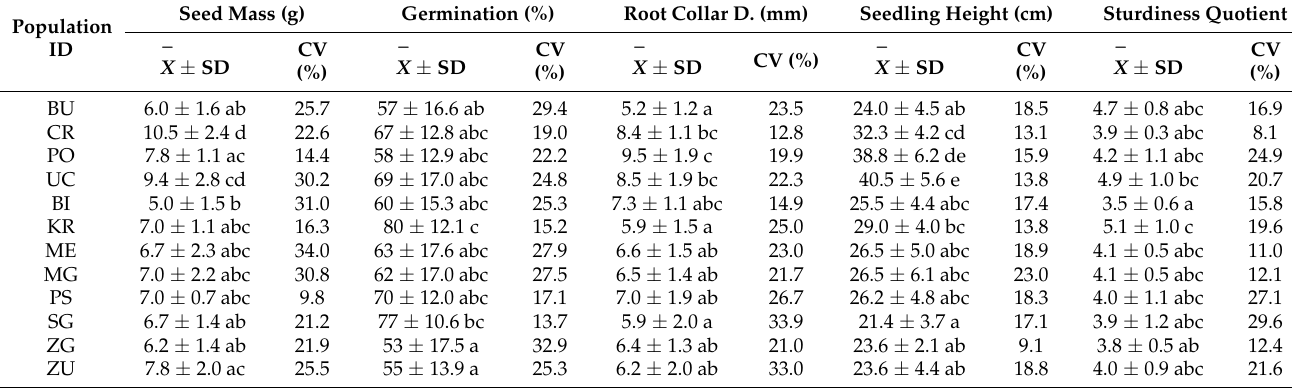
Table 1. Arithmetic means (X ), standard deviations (SD) and coefficients of variation (CV) for seed mass (SM), germination rates, seedling height (SH), root collar diameter (RCD) and sturdiness quotient (SQ) in 12 sweet chestnut populations. Popu- lation ID: BU—Buje; CR—Cres; PO—Poreˇc; UC—Uˇcka; BI—Bilogora; KR—Krndija; ME—Medvednica; MG—Moslavaˇcka gora; PS—Psunj; SG—Samoborsko gorje; ZG—Zrinska gora; ZU—Žumberak. Means marked with different letters were significantly different according to the Tukey–Kramer multiple comparison test, at p ≤ 0.05